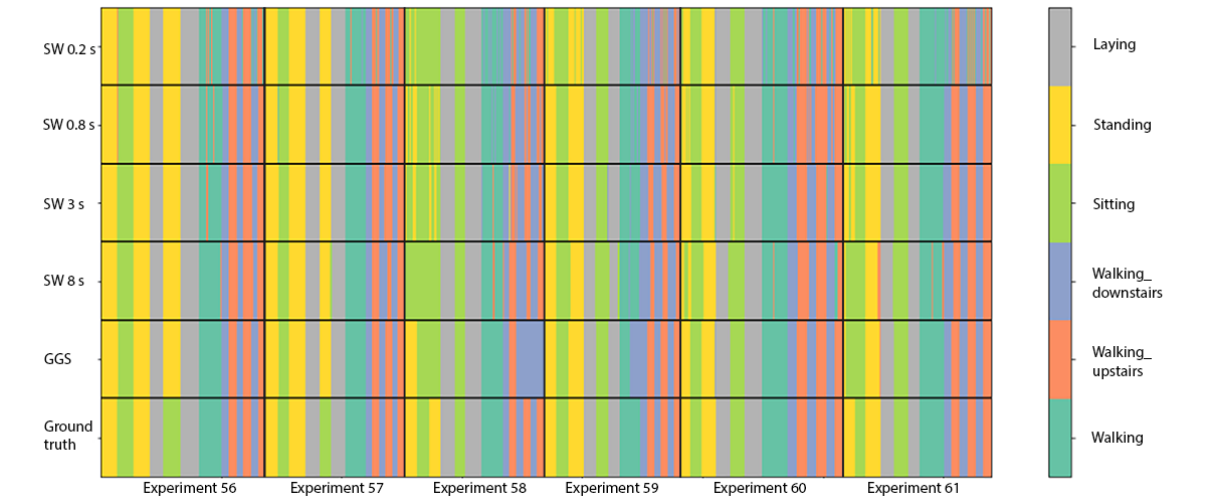
Figure 8. Predictions using 4 different fixed-sized sliding windows (SWs) and greedy Gaussian segmentation, as well as the ground truth for the 6 test